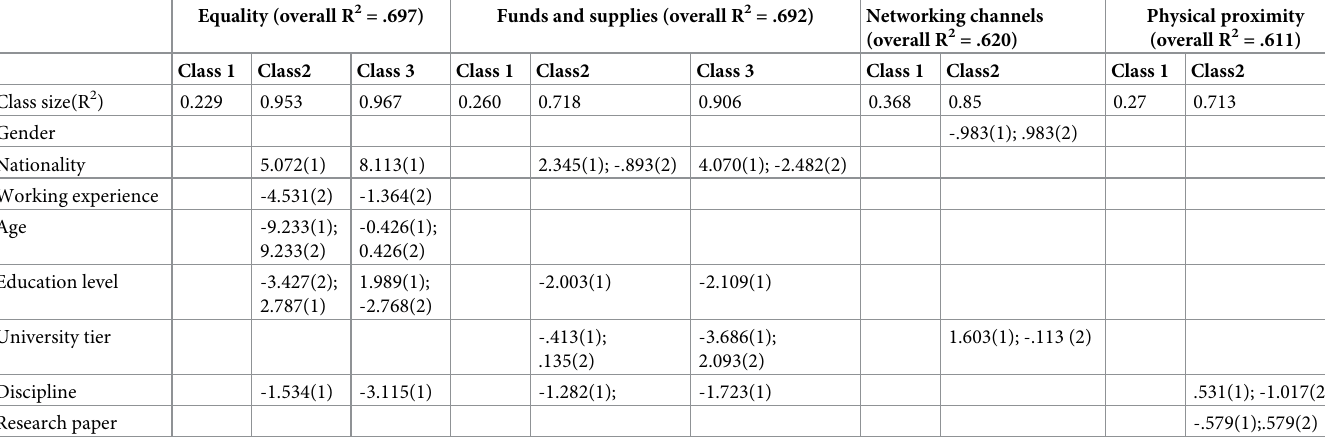
Table 4. Determinants on collaboration prerequisites (Latent class regression results summary). Equality (overall R 2 =